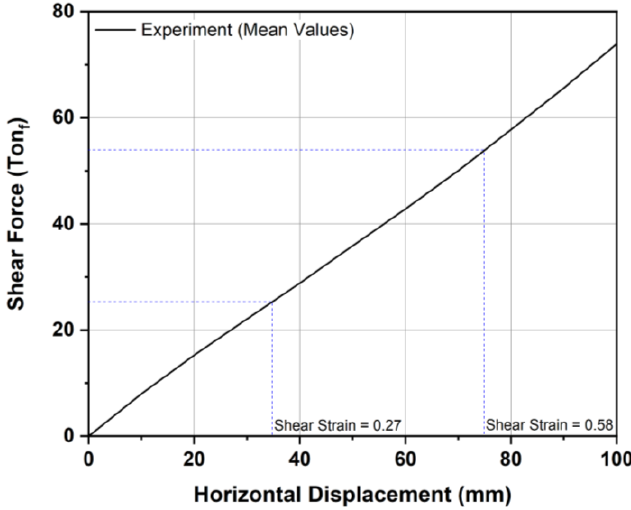
Figure 3. Shear force (red line) and displacement (blue line) graph through performance evaluation